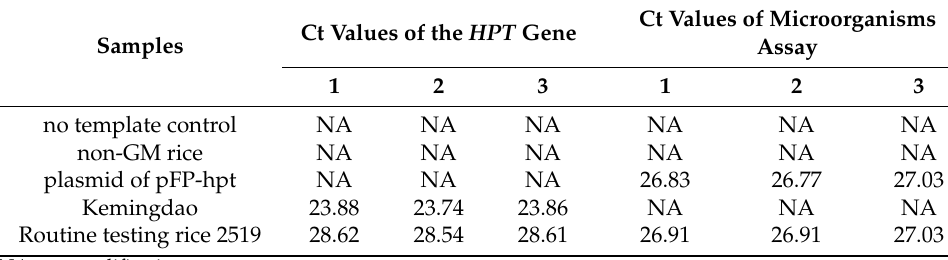
Figure 6. Results of qualitative duplex PCR amplification. Lane M: DL 2000 DNA Marker. Lane 1: no template control, Lane 2: non-GM rice, Lane 3: pFP-hpt plasmid, Lane 4: Kemingdao, and Lane 5: routine testing rice material 2519; each template was run with two parallel reactions. Table 5. Results from duplex qPCR amplification.